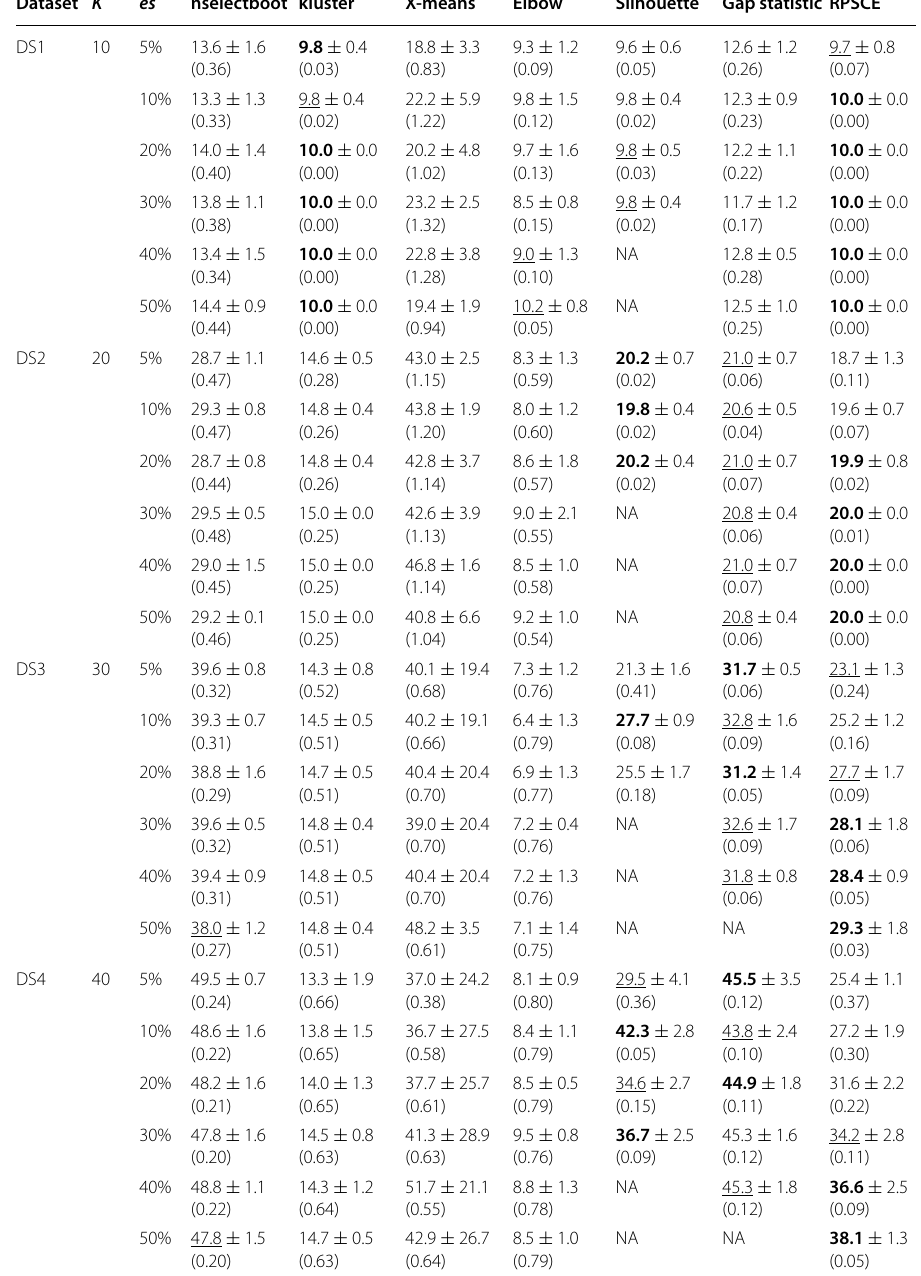
Table 6 Comparison of the estimated number of clusters produced by different methods on the synthetic datasets Dataset